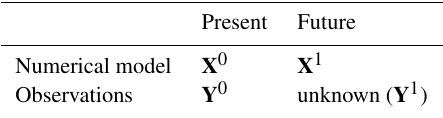
Table 1. Representation of bias correction in the context of climate